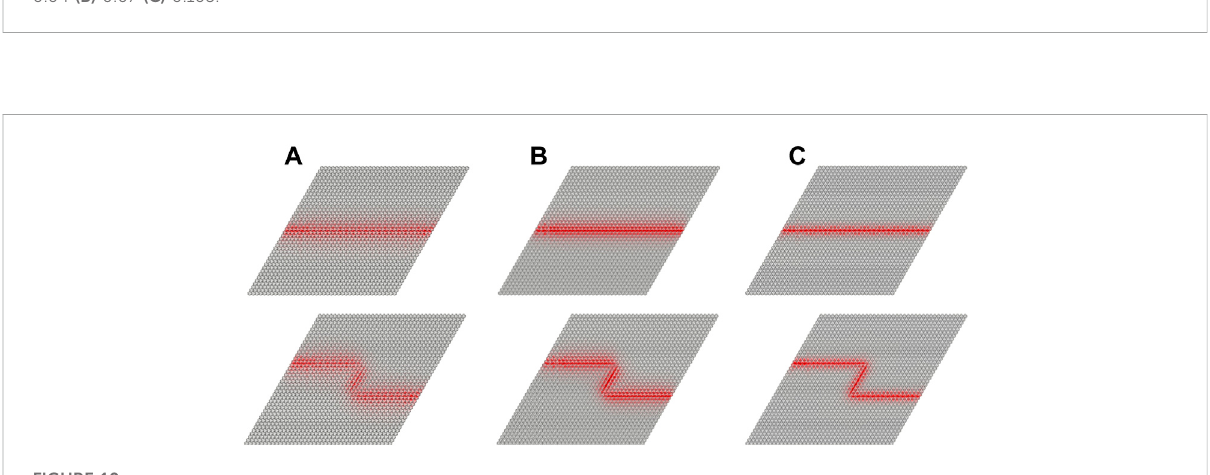
FIGURE 10 Topologically protected elastic wave propagation modes along optimized straight and Z-shaped waveguides with a width of the normalized common bandgap as (A) 0.04 (B) 0.07 (C) 0.105.